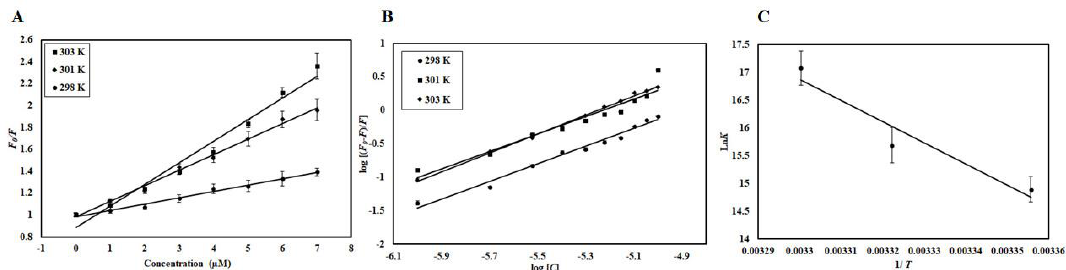
Table 2. Thermodynamic parameters of CDK6-EA interaction.